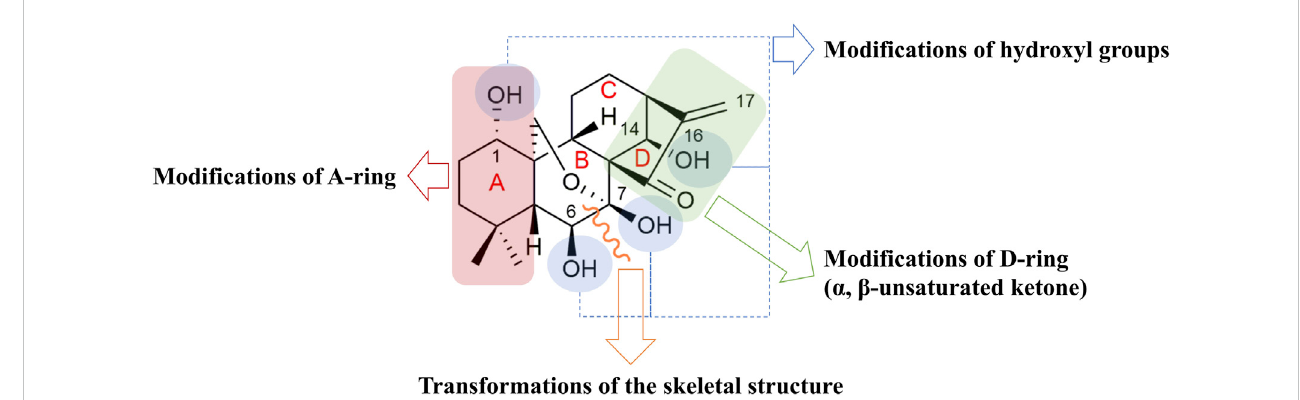
FIGURE 2 Typical optimization sites and molecular structure of